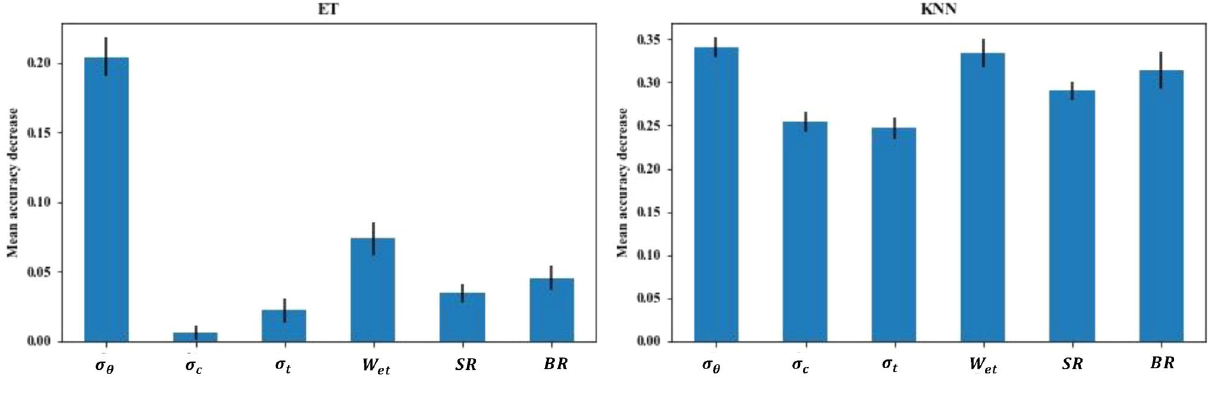
Figure 5. The mean decrease accuracy graph of ET and KNN